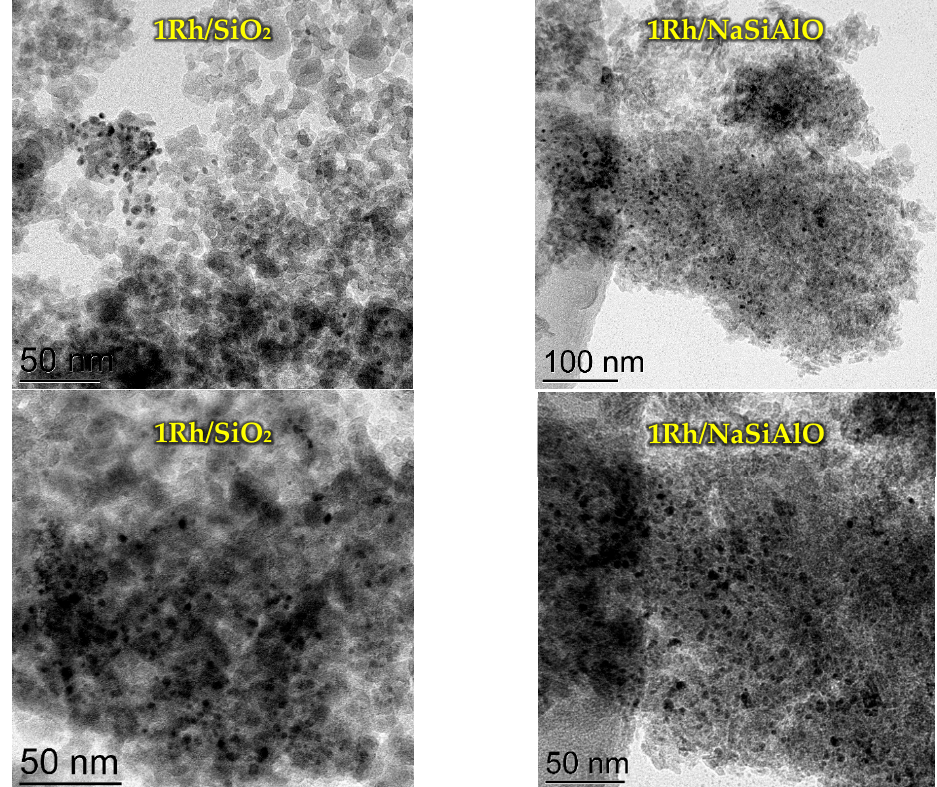
Figure 6. TEM images of the reduced H 2 catalysts with Si-containing supports. The distribution of Rh particles by size (Figure 7) differs from the sample 1Rh/SiO 2 initially calcined in air to a reduced one. It can be seen that the distribution became bi- modal, a maximum at 4 nm disappeared and two smaller maxima appear at 2 and 5 nm (seemingly because of reduction). Moreover, in the case of the sample 1Rh/NaSiAlO, it became possible to reveal the rhodium nanoparticles on the surface only after the reduc- tion. Figure 8 provides TEM images of the reduced samples 1Rh/CaMgAlO and 1Rh/Al 2 O 3 . It can be noticed that, after the reduction, the nanoparticles of Rh appeared, but the numbers of observable particles for these samples are less than for the samples with silica-based supports. Generally, it can be seen that all the samples being reduced demonstrate the nanoparticles of Rh, while only silica-based ones do in the case of cal- cined in air samples.